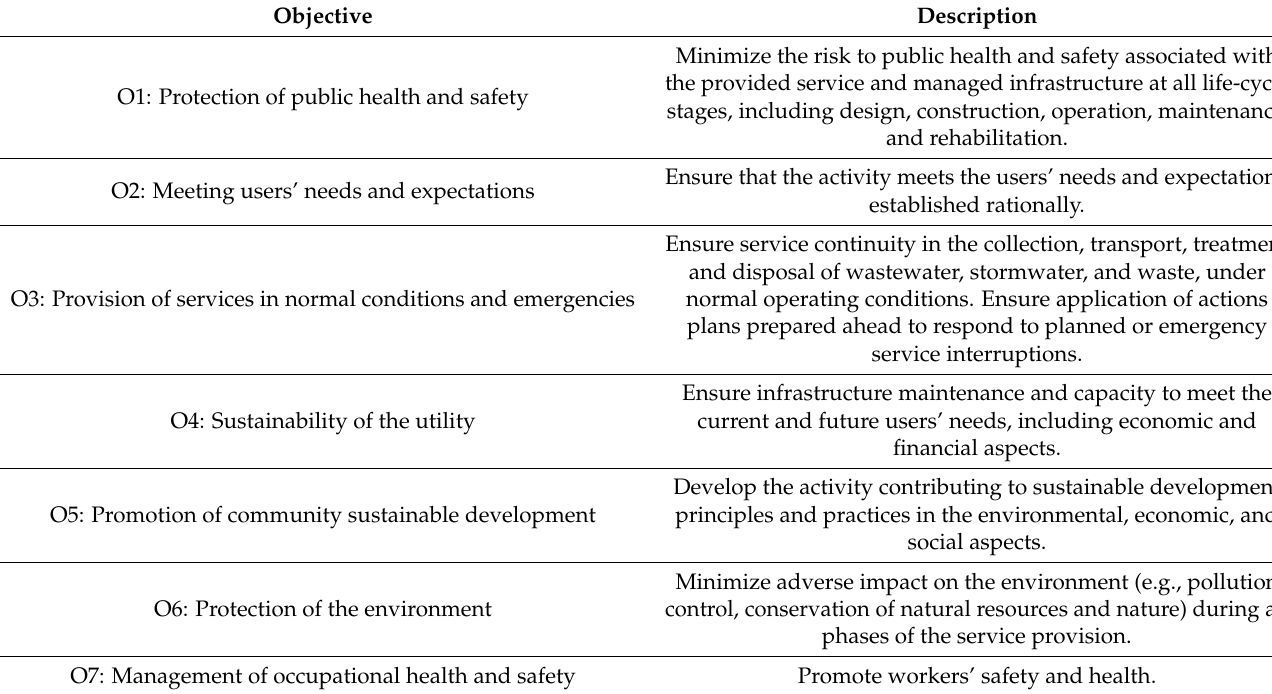
Table 3. Strategic objectives for wastewater utilities.